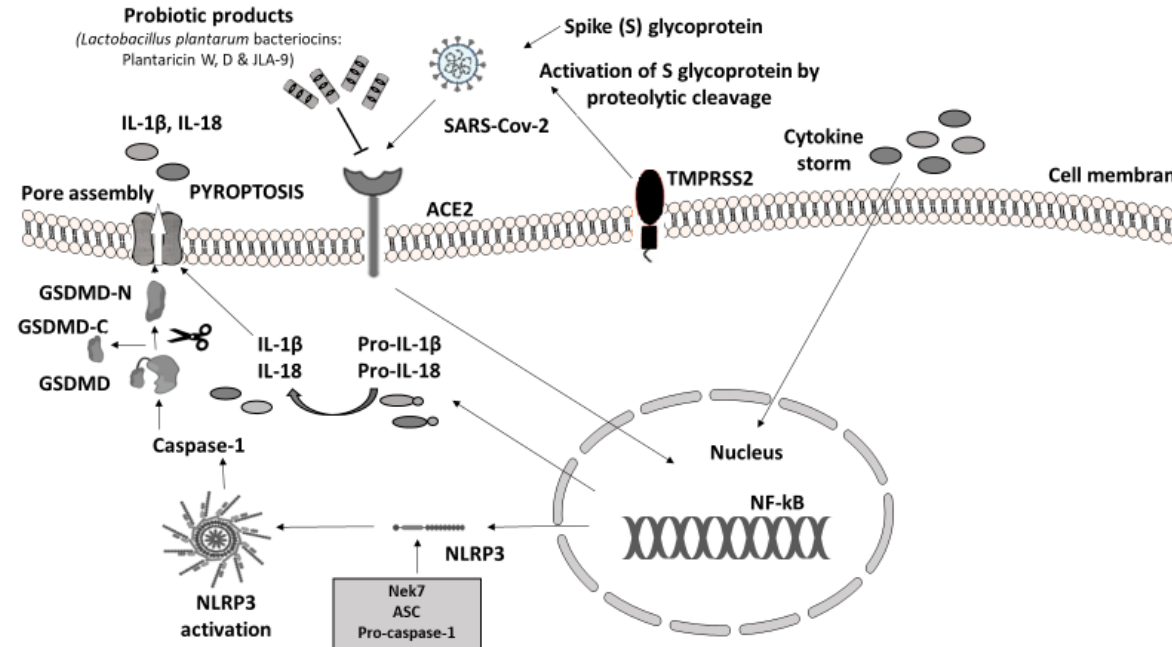
Figure 3. Probiotic bacteria products blocking ACE2 receptors may attenuate COVID-19 infection. Immune response to SARS-CoV-2. Virus invasion is carried out through ACE2 receptor and viral protein S (Spike S glycoprotein) is activated by TMPRSS2 leading to the proinflammatory cytokine cascade. The massive release of cytokines (IL-1 β , IL-2, IL-7, IL-8, IFN γ , TNF α , IP10, etc.) from innate immune cells induces the activation of NF-kB signaling pathway that regulates the transcription of NLRP3 inflammasome-related components as well as pro-IL-1 β and pro-IL-18. As soon as it is formed, NLRP3 inflammasome cleaves pro-caspase-1 and converts it into its active form, caspase-1 [23,62,63]. Subsequently, caspase-1 proceeds with the cleavage of inactive precursors pro-IL-1 β and pro-IL-18 to their mature forms IL-1 β and IL- 18 respectively; at the same time GSDMD is cleaved by the same protease in two domains, an N-terminal and a C-terminal. Following the N-terminal fragment of GSDMD assembles pores in the plasma membrane, inducing pyroptosis and cell death [23]. Experimental studies have shown that SARS-CoV-2 cell entry could be potentially prevented through the antagonistic effect of specific probiotic strains. PB, except for their ability to inhibit the adhesion of pathogens in the intestinal epithelium, compete with pathogens for nutrients and produce antimicrobial substances (e.g., bacteriocins), providing immunomodulatory action and enhancing epithelial barrier function [64]. Their anti-inflammatory effect suppresses cytokine production. Additionally, SARS-CoV-2 evokes inflammation by infecting host cells through the ACE2 receptor and TMPRSS2 inducing proinflammatory cytokine release. Lactobacillus plantarum metabolic product (Plantaricin) blocks the entry of SARS-CoV-2 by binding with ACE2 [21,23,65 – 67]. Parts of this figure were created with BioRender (https://biorender.com) and MOTIFOLIO Download Free Sample (https://www.motifolio.com/sampleslides.html).